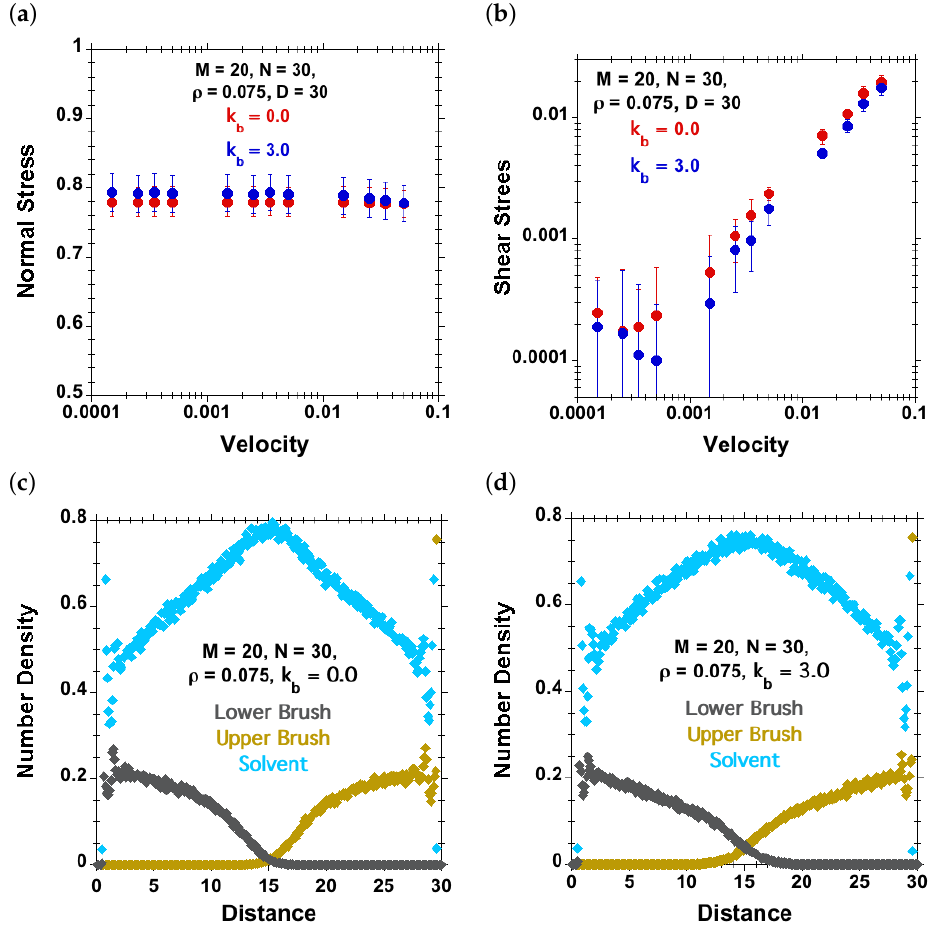
Figure 11. Effect of chain stiffness (red dots for k b = 0 and blue dots for k b = 3) for M = 20, N = 30, ρ = 0.075, D = 30 and good-solvent quality. ( a ) Normal stress against velocity; ( b ) shear stress against velocity; ( c – d ) concentration profiles of solvent (cyan), lower polymer-chains (grey) and upper polymer-chains (brown) for ( c ) k b = 0 (flexible) and ( d ) k b = 3